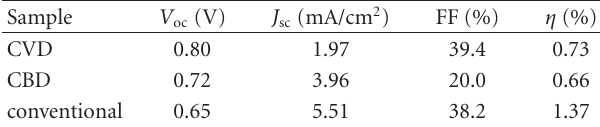
Table 1: Photovoltaic characteristics of three ZnO-nanorod dye- sensitized solar cells grown by the one-step CVD, two-step CBD and conventional methods. The incident light intensity is 85 mW/cm 2